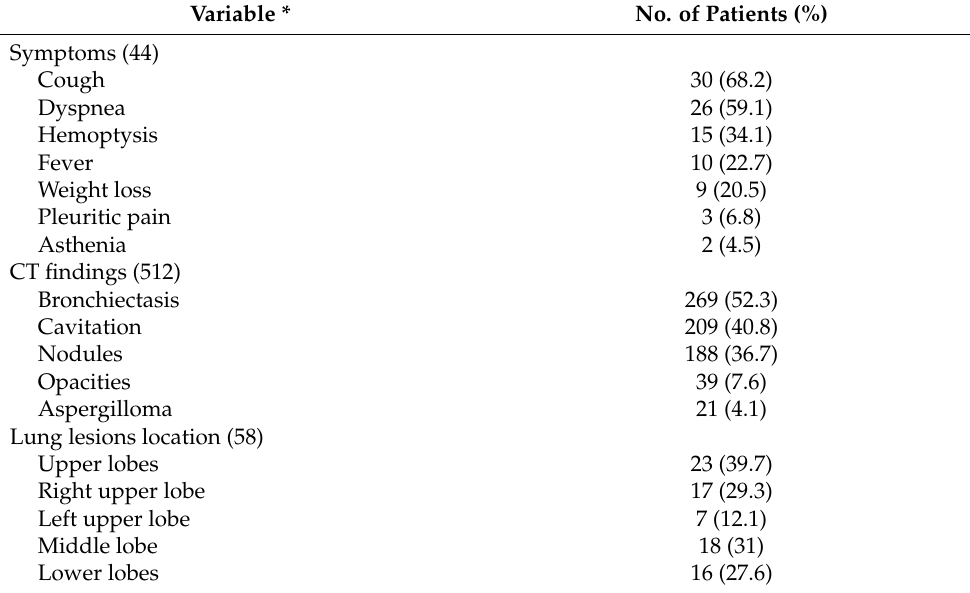
Table 2. Clinical presentation reported in 44 patients and radiology findings reported in 512 patients with NTM and Aspergillus co-infection. Lung lesions locations were mentioned in 58